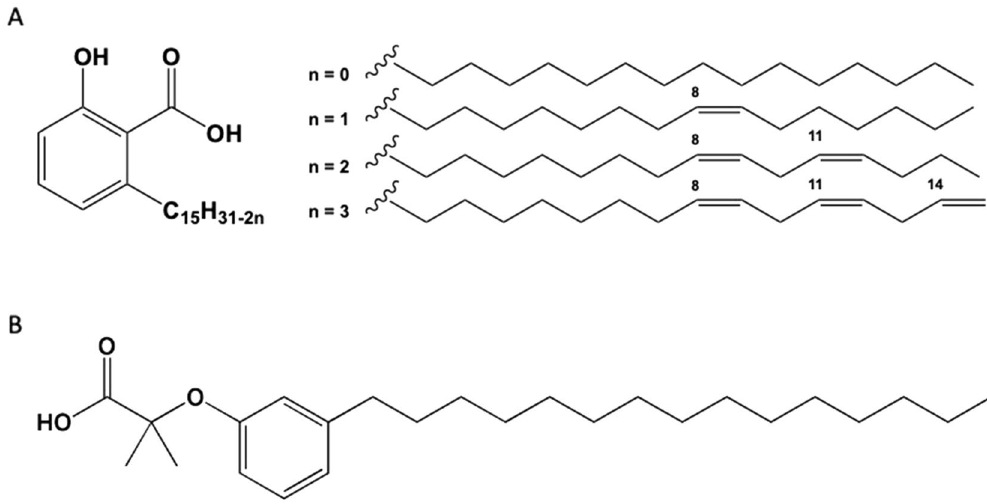
Figure 1. Mixture of anacardic acids ( A ) and cardanol ( B ) present in cashew nutshell liquid (CNSL). LDT11 corresponds to isolated saturated molecules of A (n = 0) and LDT409 was synthesized from saturated cardanol ( B ). Details on chemical design and structure are described elsewhere 28